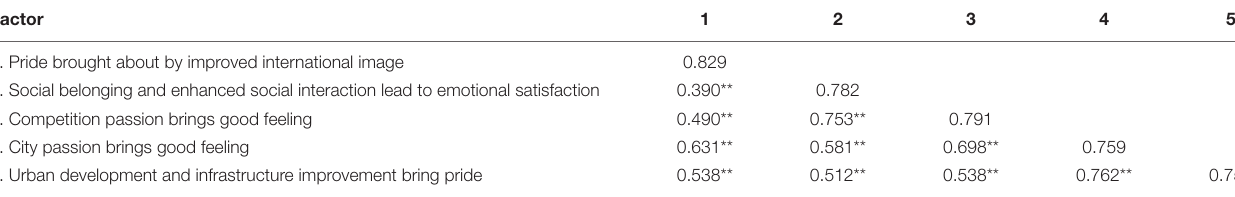
TABLE 4 | The square root and average variance extracted (AVE) correlation matrix of the psychological income.